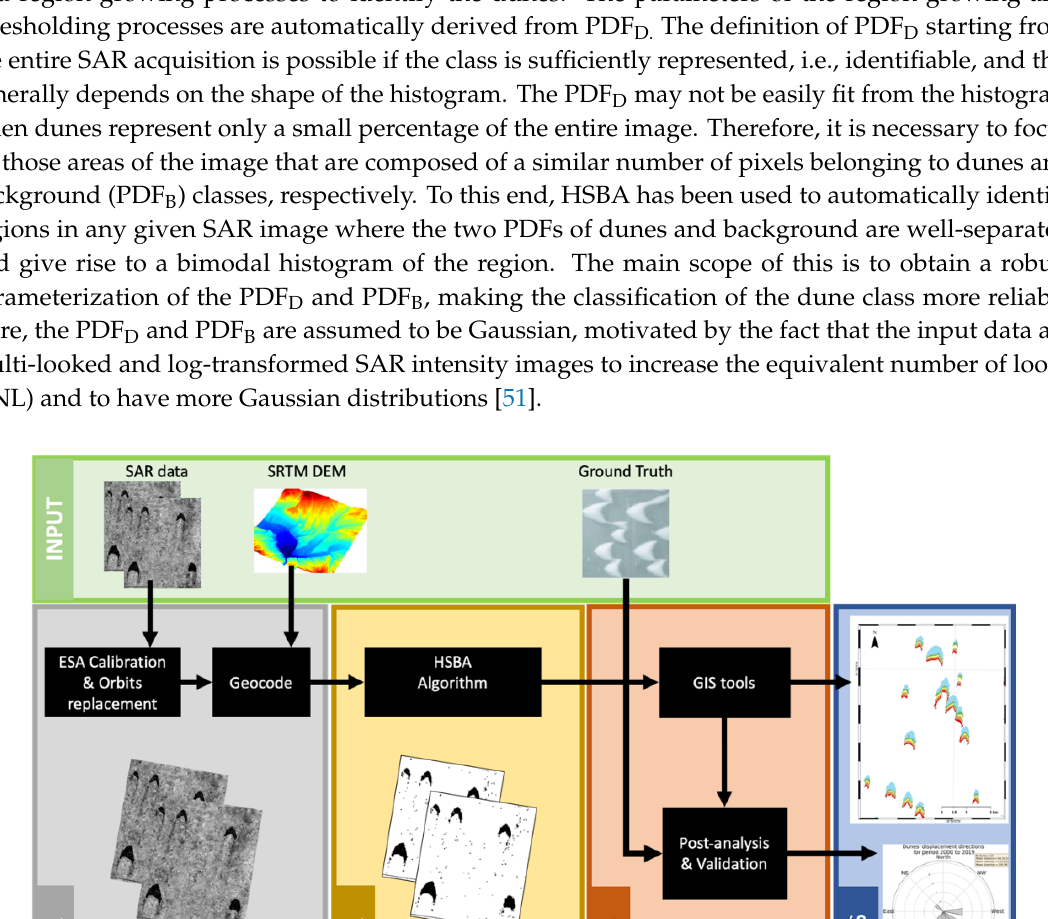
Figure 4. Optical ( A ) and SAR ( B ) view over the South Rayan dune field, delimited by the red polygon. Barchan dunes are the dark areas within the red line in ( B ). ( C ) shows the intensity of the SAR backscatter signal in decibels over the yellow rectangle in B in radar coordinates. ( D ) shows the profile of the vertical red line in Figure ( C ) for two different SAR data acquired on 2004/07/07 and 2010/09/09 depicting a very low intensity of signal over the barchan dunes.